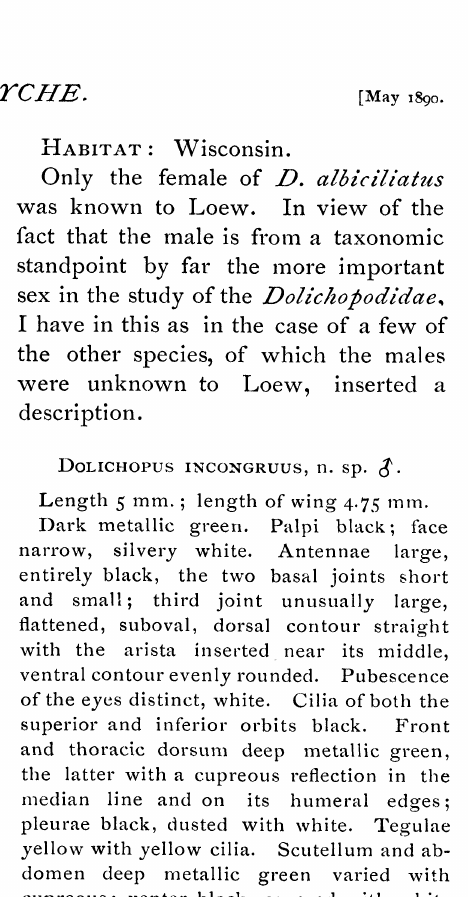
Coxae opaque black, tipped with yellow; the anterior pairs with several curved black bristles on their fore faces; all the femora black, with metallic green re- flection, broadly tipped with yellow; anterior tibiae pale yellow, with black setae, which are conspicuously long on the fore pair; ante- riot ta.’si pale yellow, blackened from the tip of the first joint; hind femora ciliated with long and delicate hairs on their inner faces; hind tibiae slightly incrassated, pale yellow with their apical third black hind tarsi black, the metatarsal joint slightly incras- sated. Halteres dull yellow. Wings gray- ish hyaline veins black; the juncture of the first logitudinal vein with the costa thickened, though not to the degree observed in the males of some allied species; last section of the fourth vein appearing considerably steeper than in the and meeting the costa nearer the end of the third